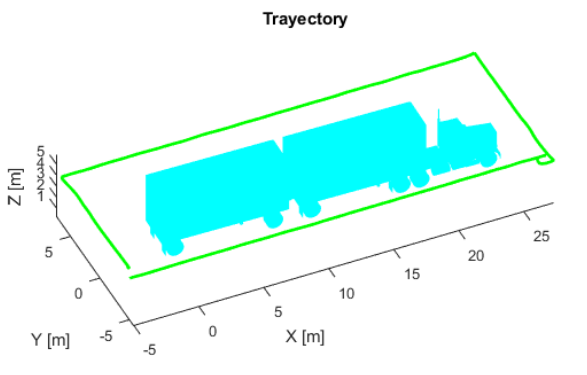
Figure 13. Proposed inspection trajectory (green). Truck 3D CAD model